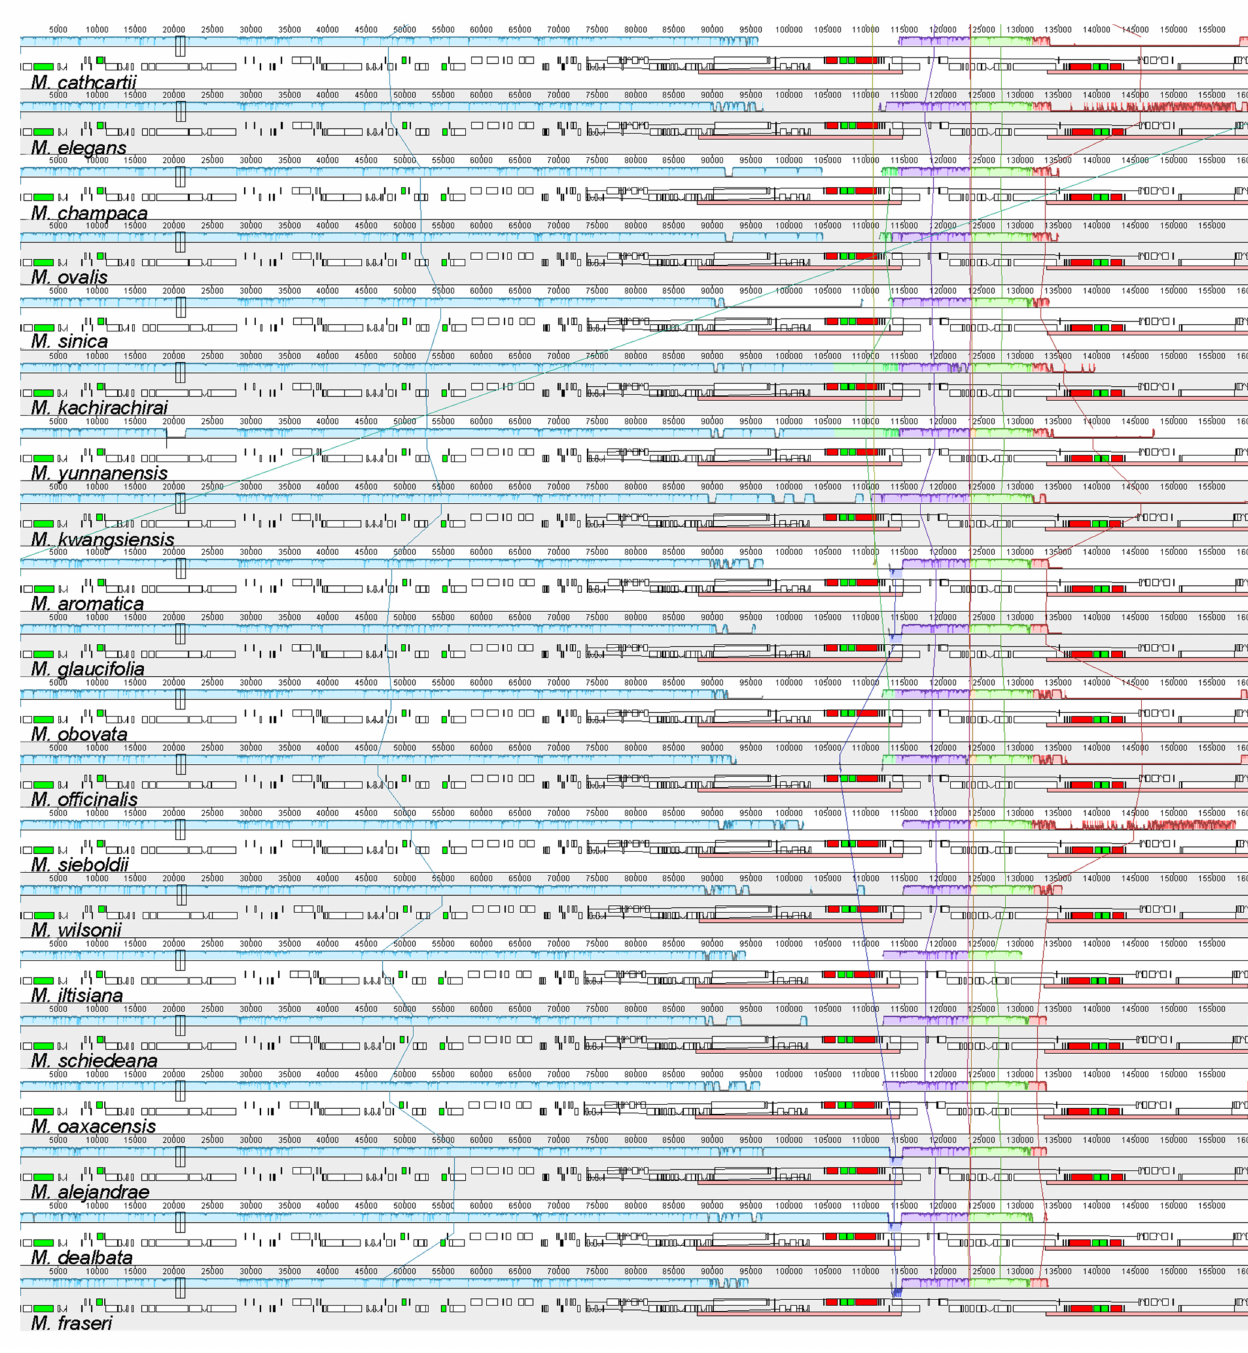
Figure 1. Mauve progressive alignment, including all 37 Magnoliaceae plastomes. Blocks of the same color connected by a line represent colinear regions. Blocks below the graphs represent coding regions. Colinear regions appear in the same order in all species, which suggests that no significant rearrangement has been